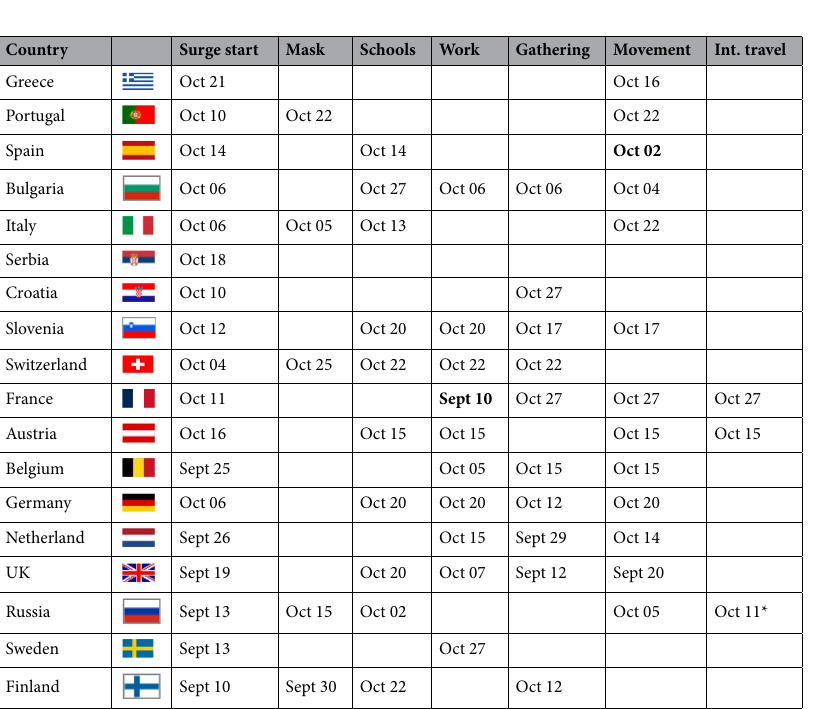
Table 3. Safety measure reinforcement dates in the September–October period. Bold: reinforcement could have reduced the surge. *Decrease of the safety